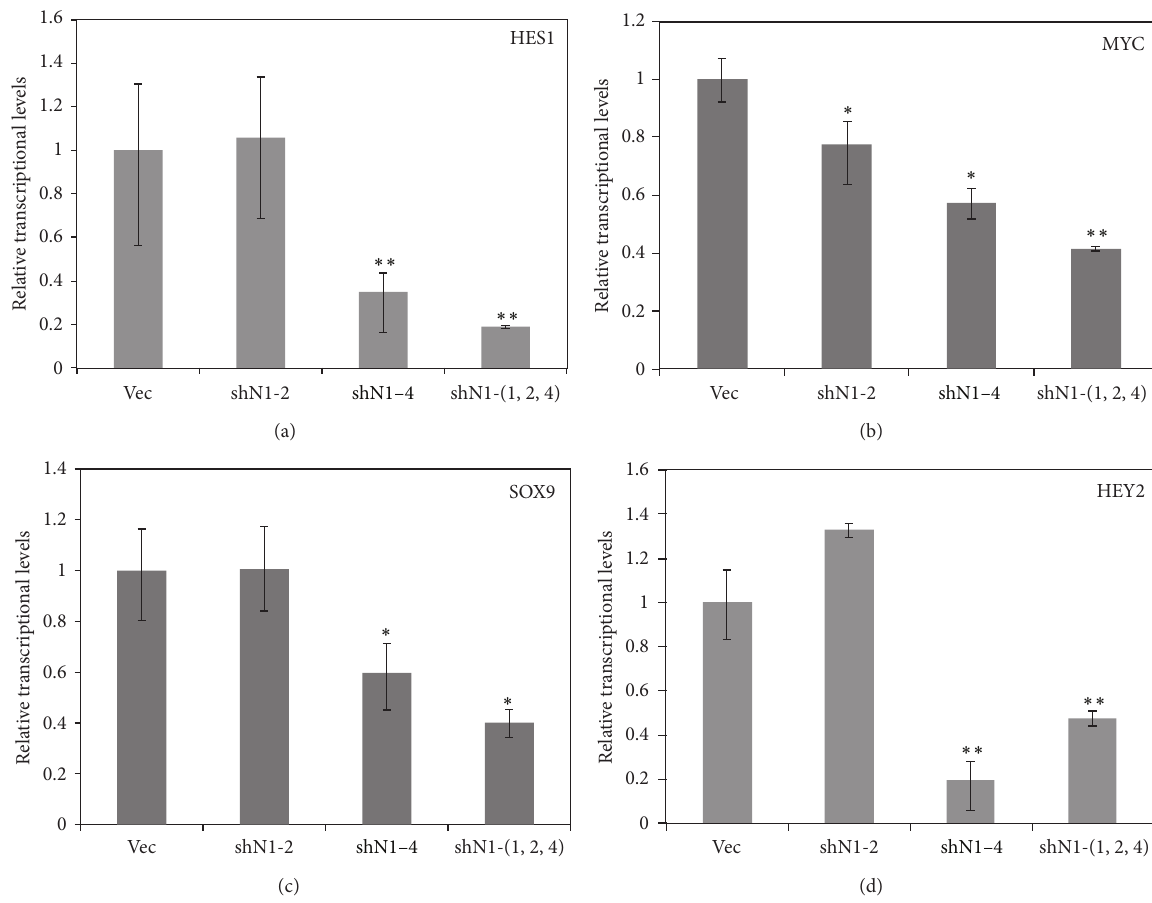
Figure 4: Inhibition of Notch signaling reduced the expression of the Notch signaling target genes. The downregulation of four members of the Notch signaling pathway (HES1, MYC, HEY2, and SOX9) was determined using real-time RT-PCR. Data are expressed as means ± SD. ∗ 𝑃 < 0.05 versus vehicle and error bars represent at least two independent experiments.